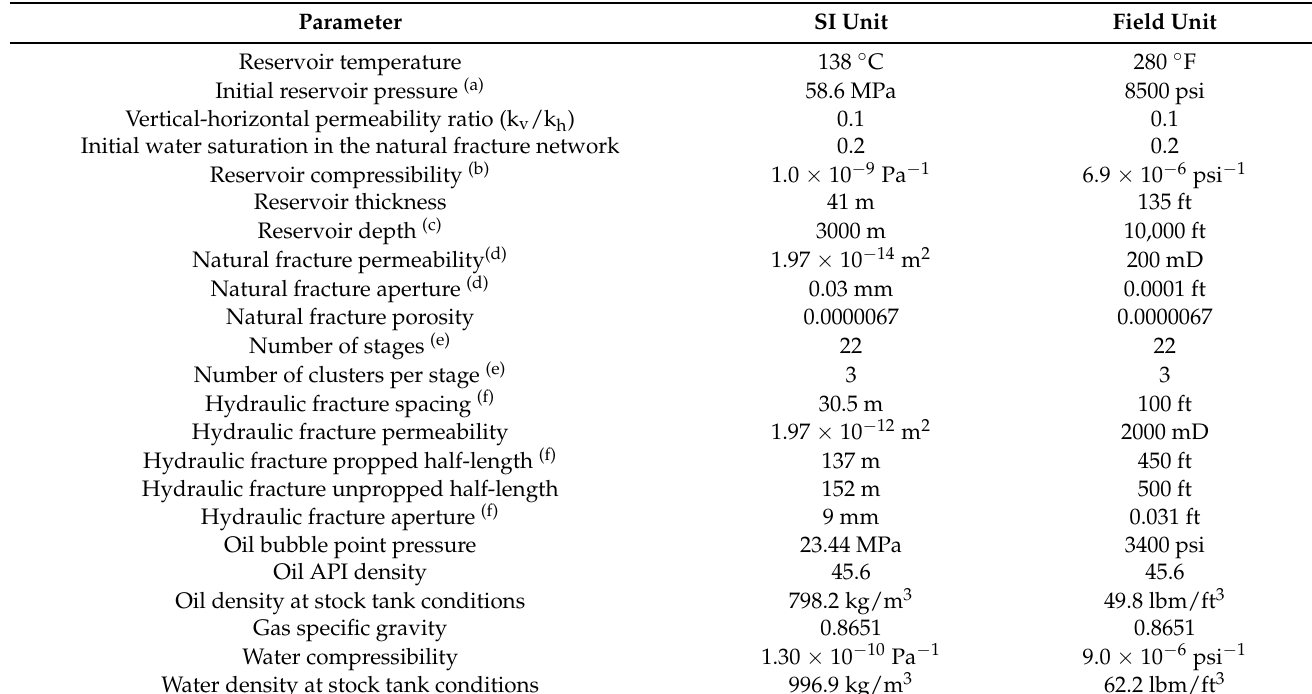
Table 2. Shale play and fluid properties.